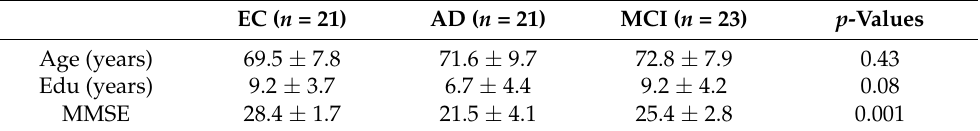
Table 1. Demographic data of participant